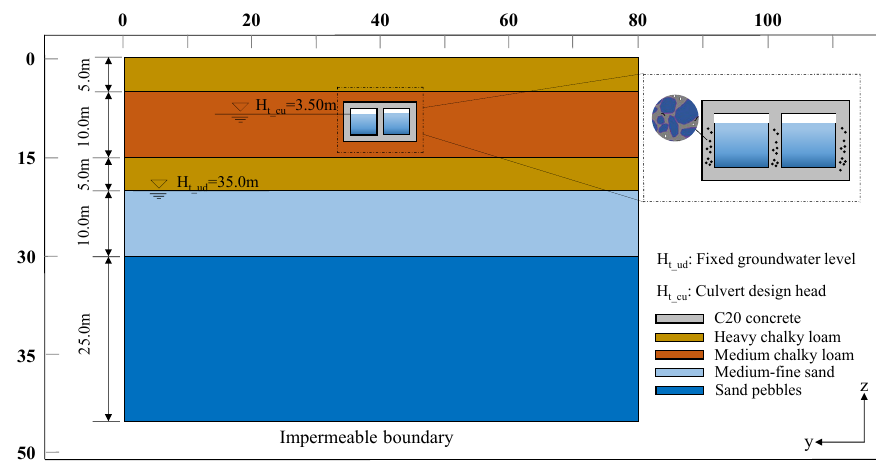
Figure 3. Geological profile of culvert engineering. Table 1. Suggested values for physical parameters of soil layers and structural materials in the site area.